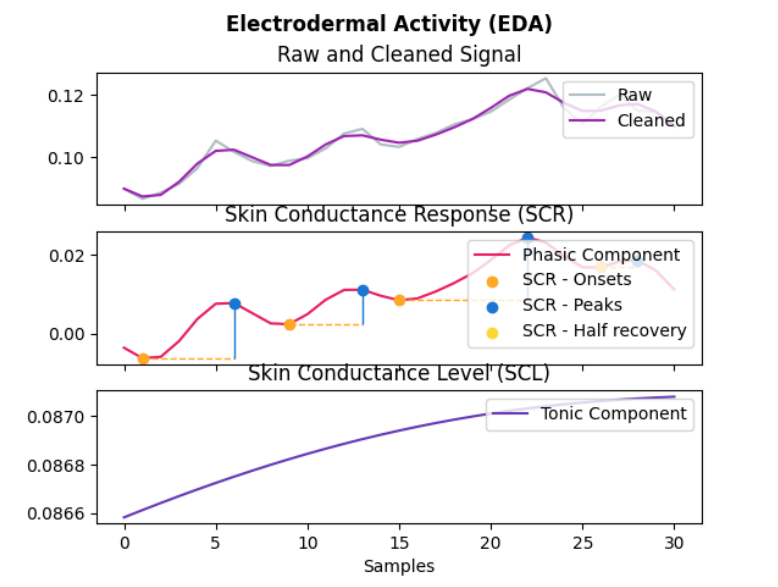
Figure 3. Galvanic skin response/electrodermal activity sample